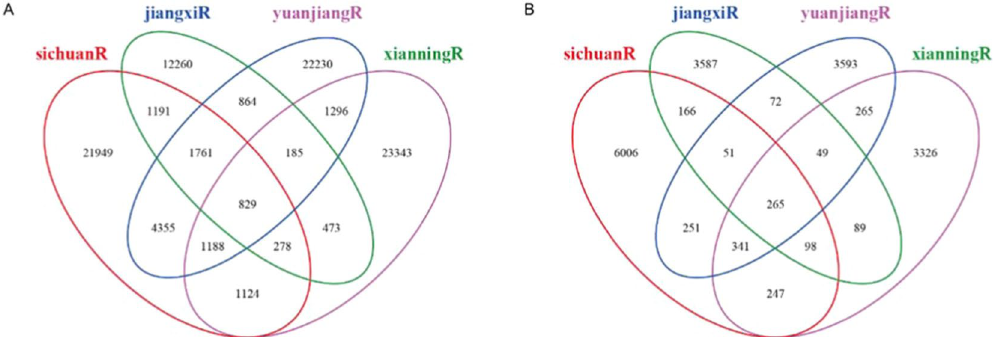
Figure 2. Venn diagram showing the number of unique bacterial ( A ) and fungal OTUs ( B ) detected in four different areas continuous cropping ramie soil